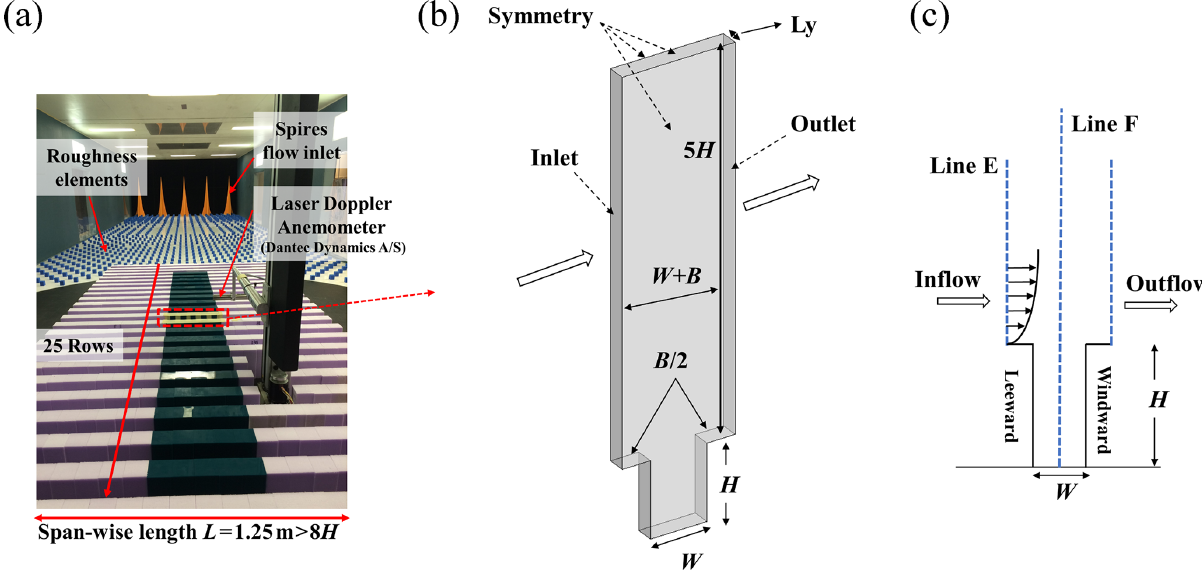
Figure 4. (a) Wind tunnel experiment in a 2D street canyon. (b) The single street canyon CFD domain setups in the scaled model, (c) the inlet profile (Line E), and measurement profiles (Line F) in the street